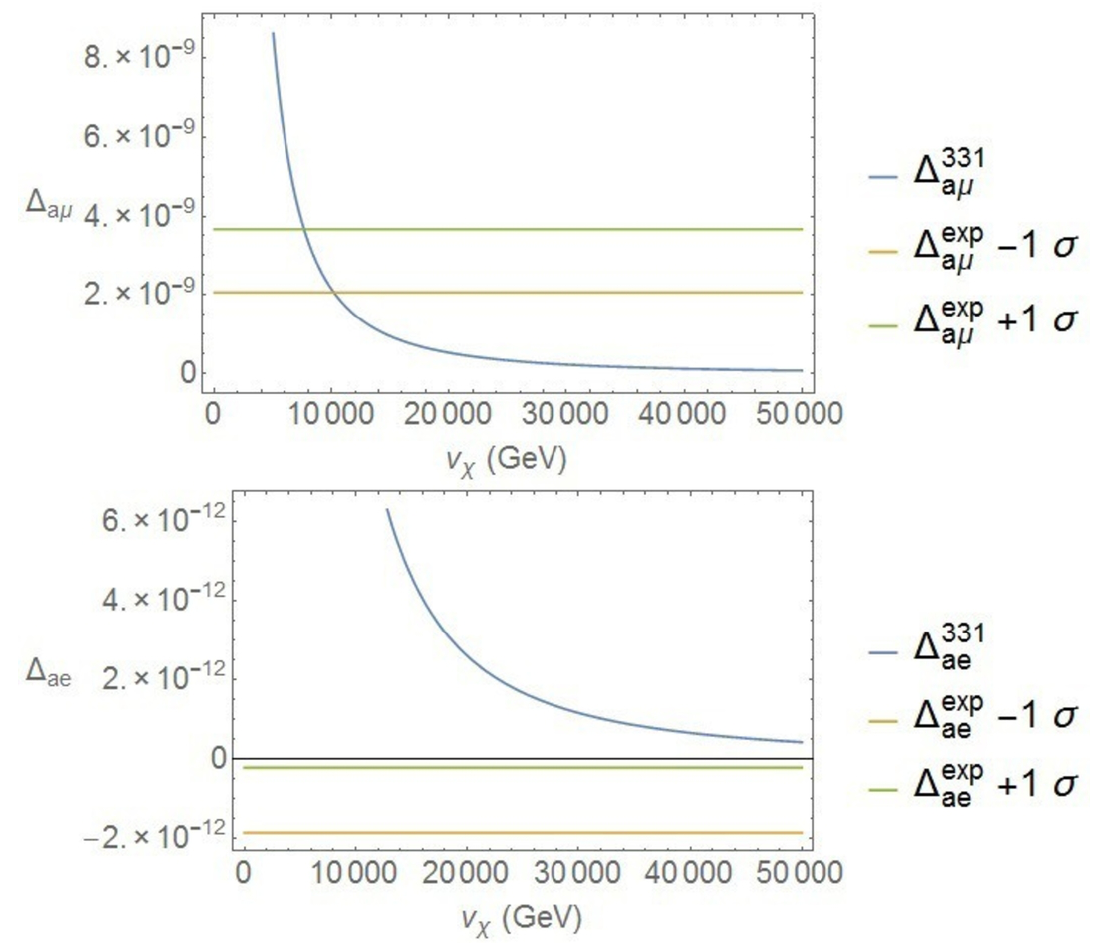
Figure 19 . (cid:1) a e (upper graphic) and (cid:1) a (cid:22) (lower graphic) taking into account only the contribution of the doubly charged vector boson U (cid:0)(cid:0) as function of v (cid:31) , with 0 < v (cid:31) (cid:20) 50 TeV. We also assume that both V L;R are the unit matrix and m Ee = m E(cid:22) = m E(cid:28) = 20 GeV. It can be seen that